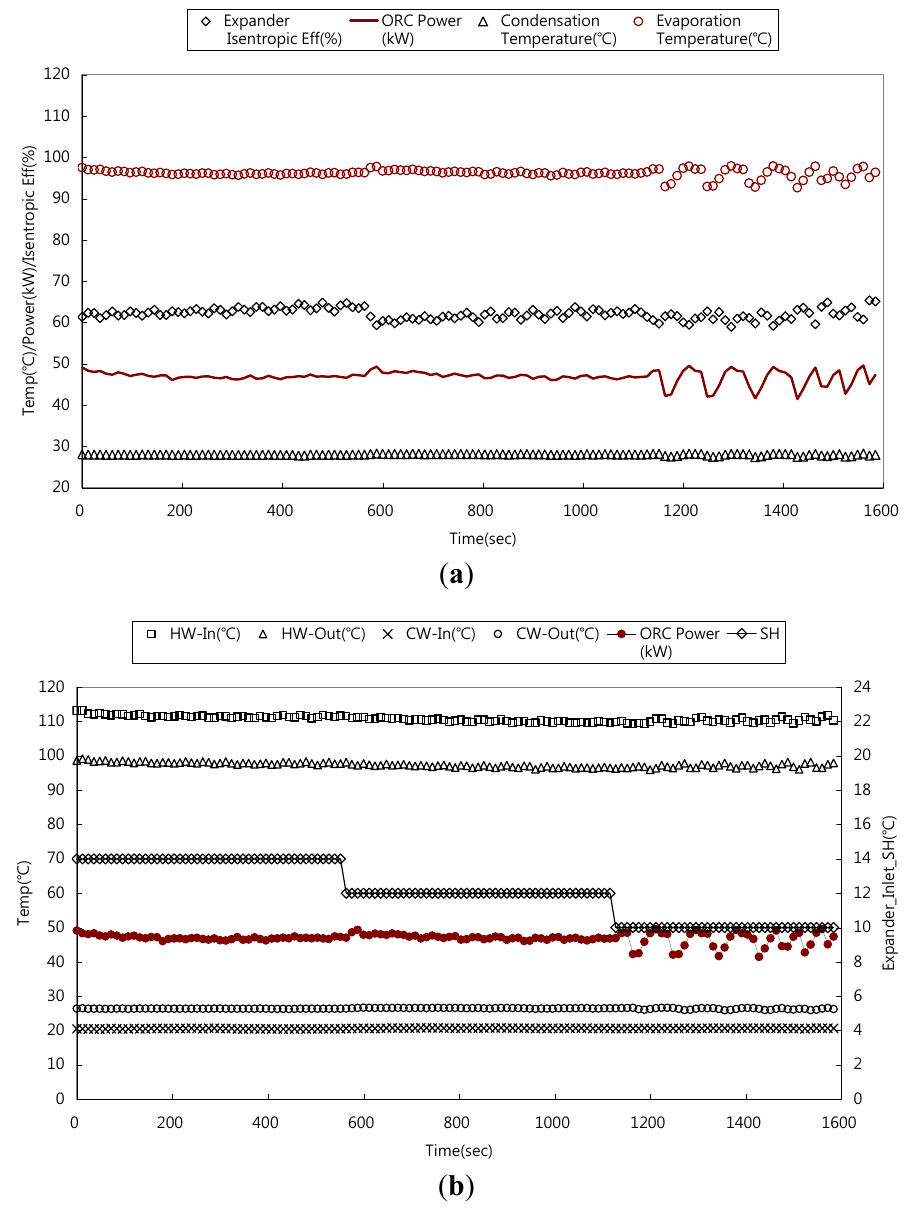
Figure 5. System response of the 50 kW ORC system with the plate evaporator subject to an exit superheat of 10, 12, and 14 °C. ( a ) Response of refrigerant side; ( b ) Response of water side and expander. (HW-in: hot water inlet, HW-out: hot water outlet, CH-in: cooling water inlet, CH-out: cooling water outlet, SH: superheat, WF: pump work (relative to full